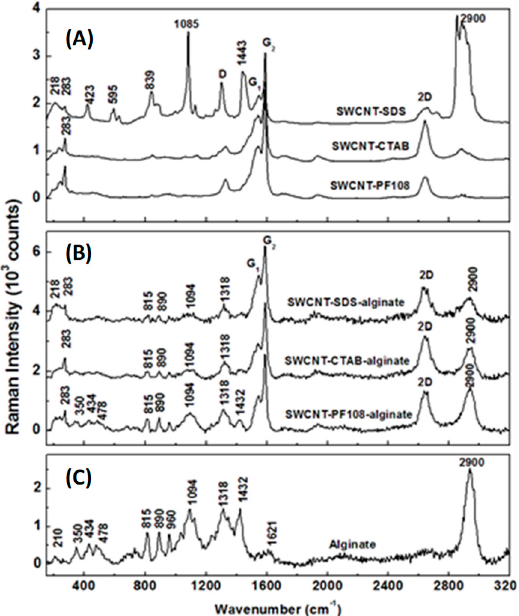
Figure 1. Raman spectra of ( A ) single-walled carbon nanotube (SWCNT) functionalized with different surfactants, ( B ) SWCNT-surfactant gel composites, and ( C ) alginate hydrogel, as labeled. For easier visualization, the Raman spectra in ( A ) and ( B ) are vertically